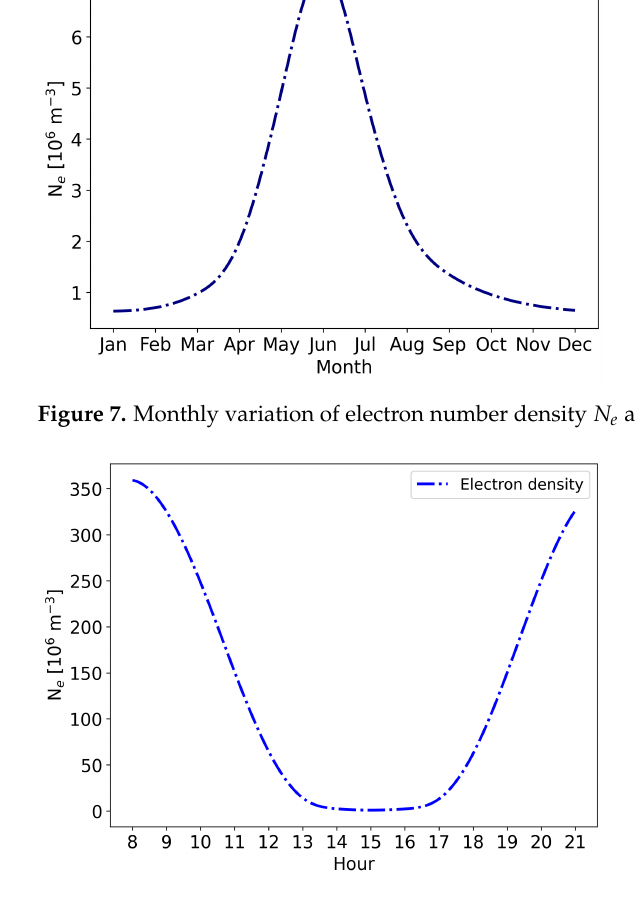
Figure 8. Hourly variation of electron number density N e at a height of 80